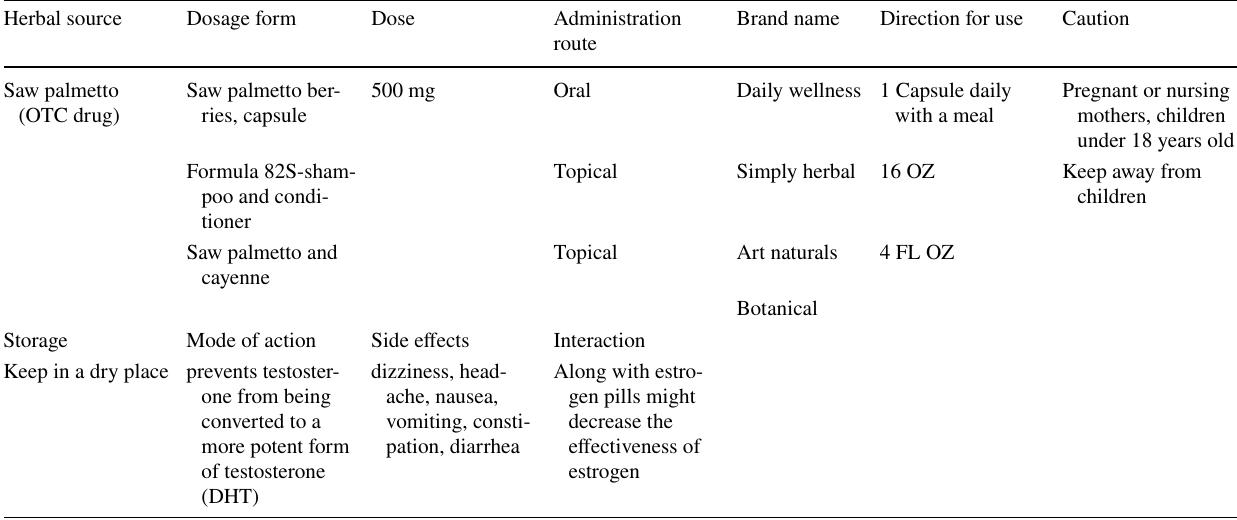
Table 6 Market formulation for Saw Palmetto Herbal source